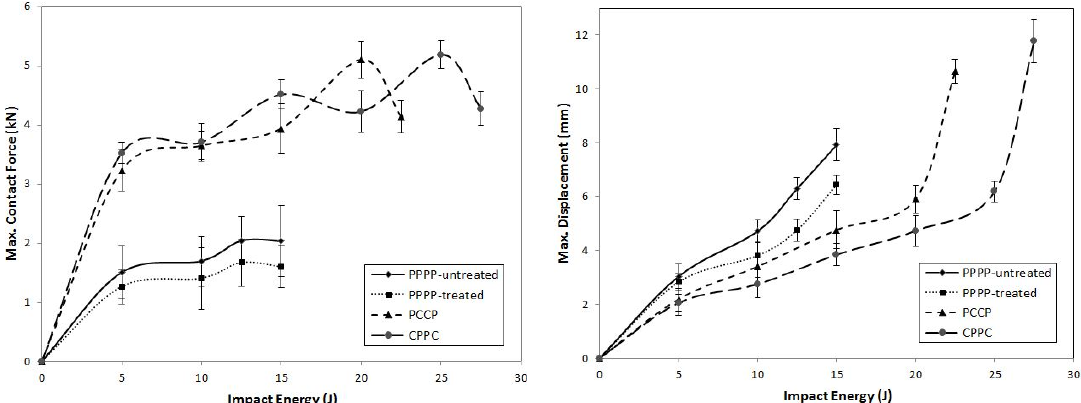
Figure 5. Maximum contact force and displacement against impact energy of the hybrid laminates at ply orientations of [0°/90°] 8 .